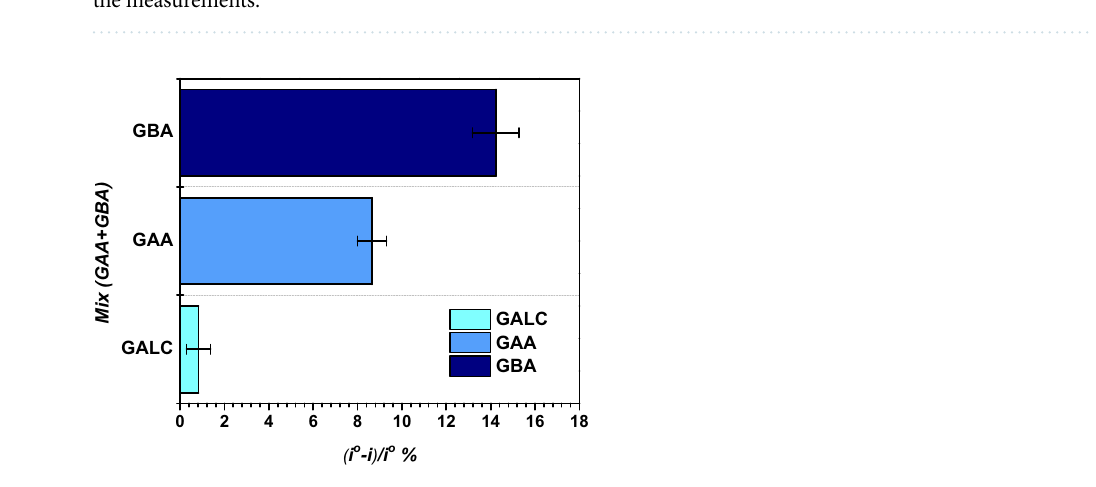
Figure 7. GAA, GBA and GALC sensors’ response after incubation each with a mixture of 0.5 ng/ml of GAA and GBA.